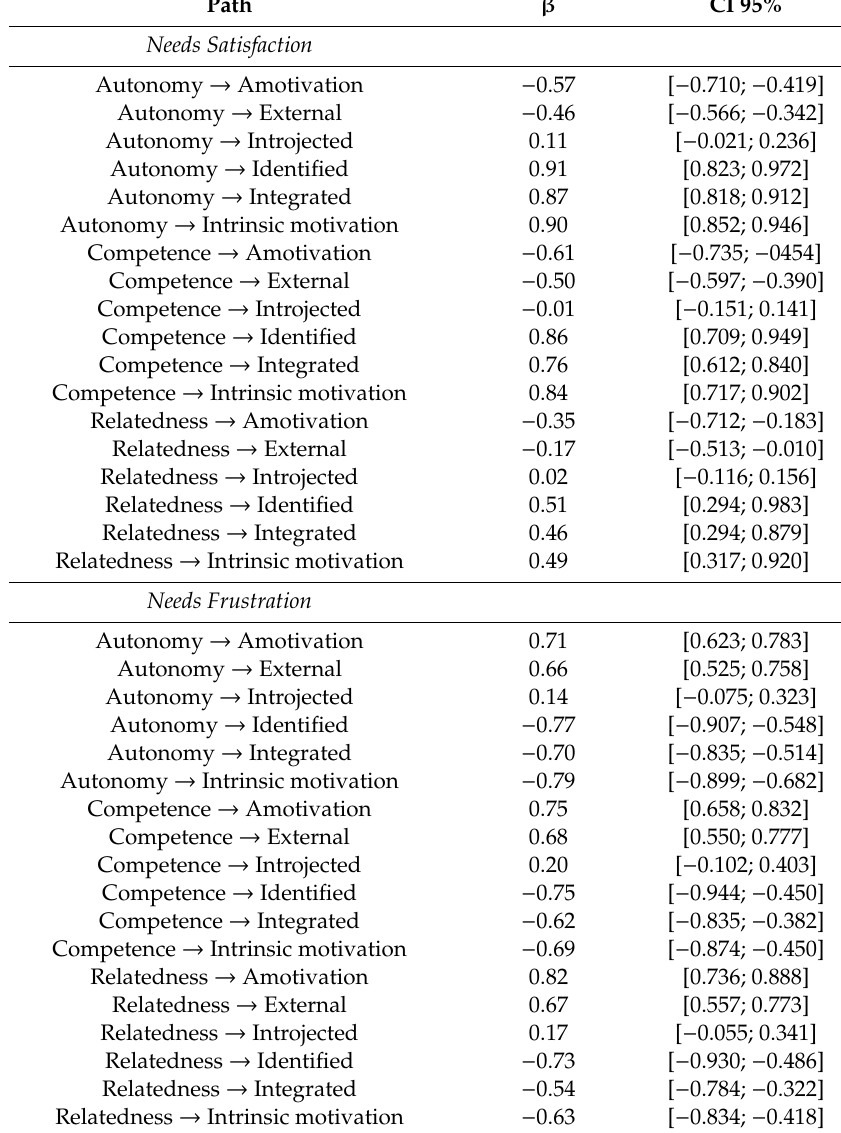
Table 4. Regression paths between needs satisfaction and frustration and types of